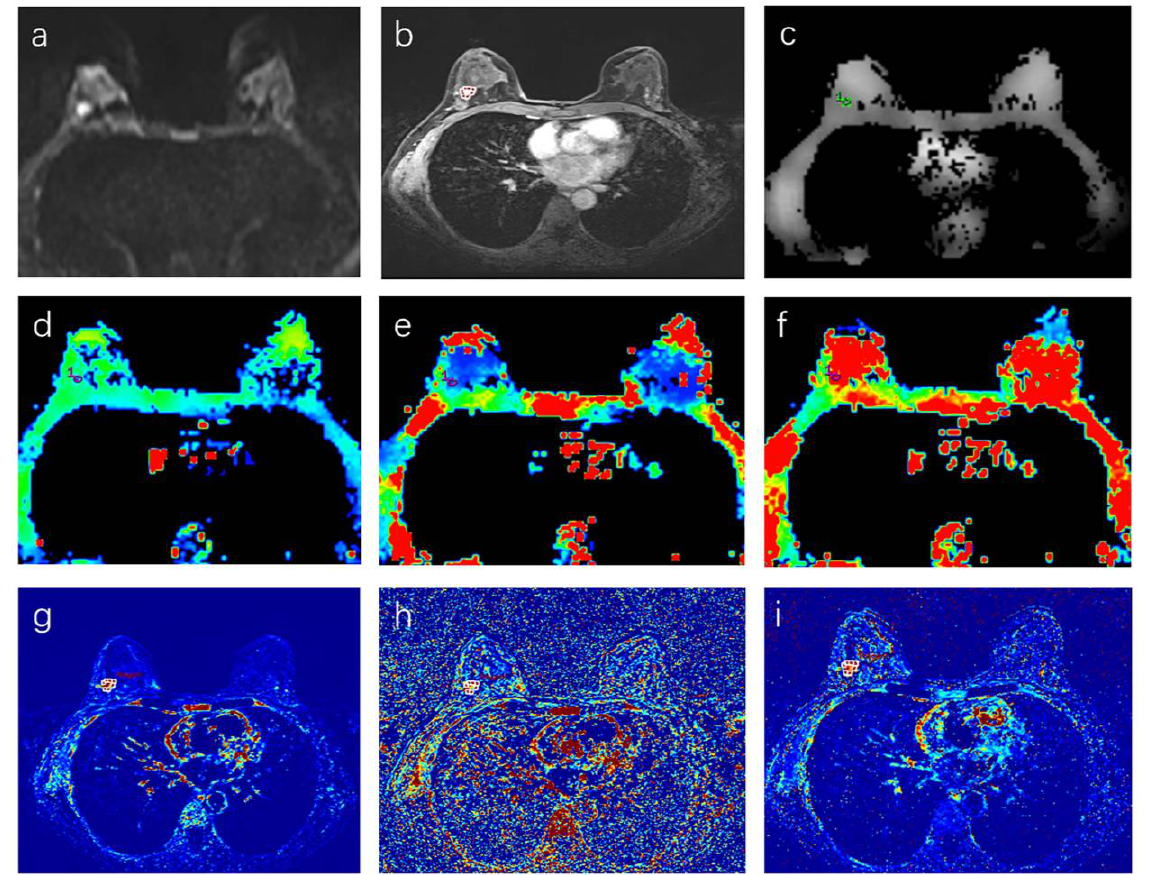
Figure 1. ( a – i ) A 46-year-old woman with a malignant BI-RADS 4 lesion in the right breast. ( a ) Diffusion-weighted imaging at b = 800 mm/s 2 . ( b ) Dynamic contrast-enhanced imaging, ( c ) ADC map, ( d ) D map, ( e ) D* map, ( f ) f map, ( g ) K trans map, ( h ) K ep map, ( i ) V e map. The circle stands for the delineated ROI.